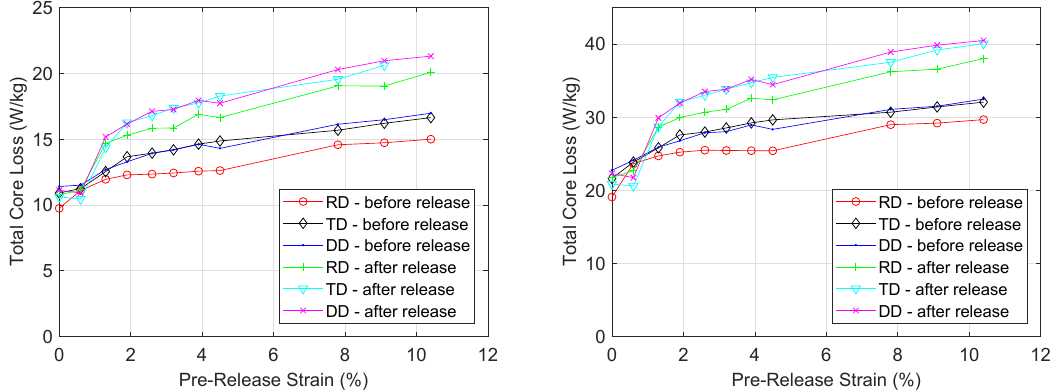
Figure 9. Evolution of total core losses under increasing levels of strain at 200 Hz and B p = 1.2 T ( left ) and at 400 Hz and B p = 1 T ( right